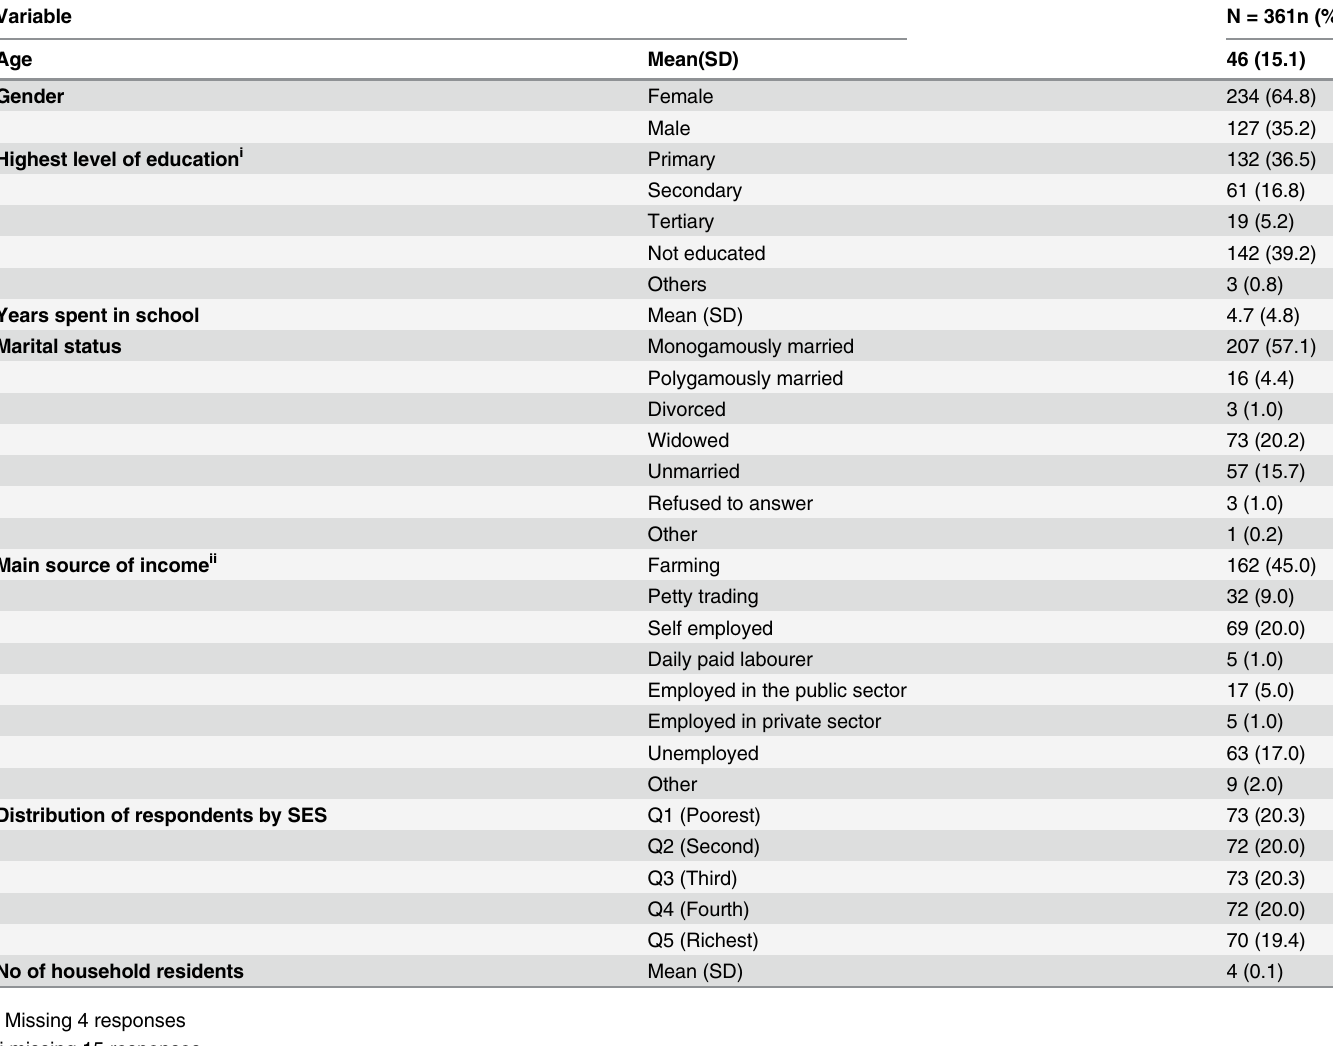
Table 1. Socio-demographic characteristics of